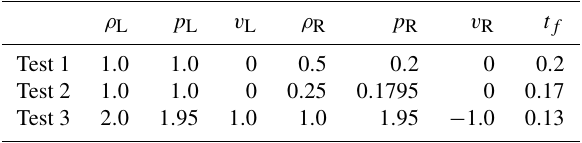
Figure 5. The effect of domain adjusting on simulation time. Panel (a) shows execution time without domain adjusting; panel (b) shows execution time with domain adjusting. Different bins represent execution time up to specific physical time indicated by horizontal axis. Table 1. Input parameters of 1-D shock tube tests.